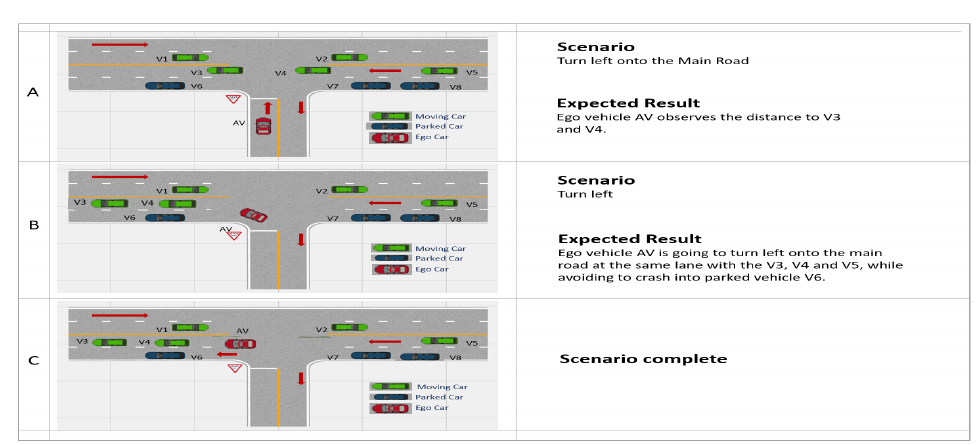
Figure 8. Turn left onto main road using Open Autonomous